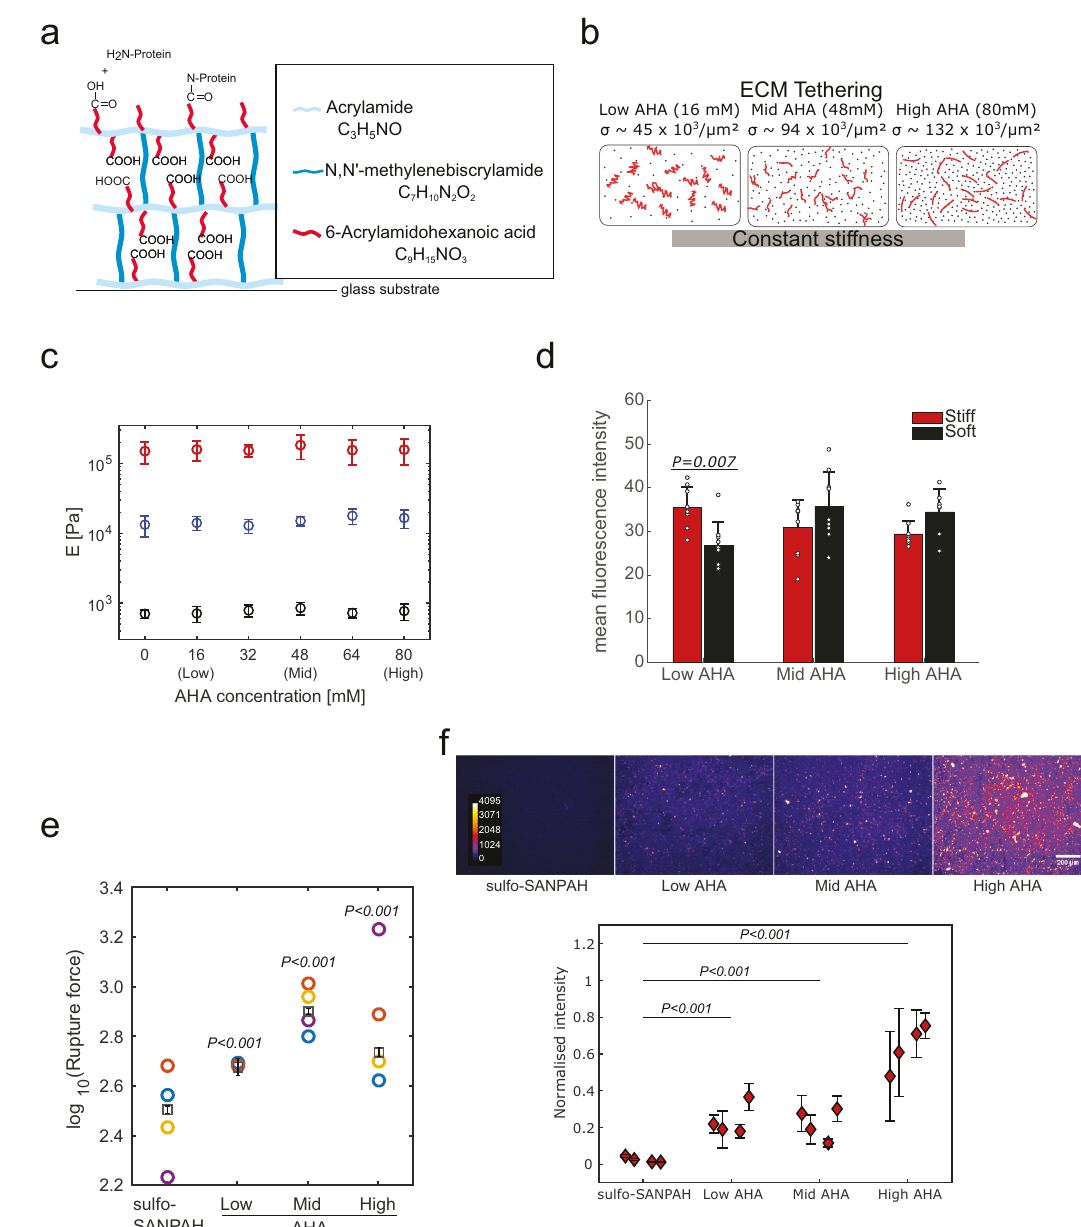
Fig. 1 StemBond hydrogels provide control over ECM density and stability independent of stiffness. a Sketch of StemBond hydrogels. PAAm are synthesised with co-factor 6-Acrylamidohexanoic acid (AHA). The AHA chains terminate with a carboxyl group which then binds primary amines of ECM proteins. b Schematic of variations in ECM tethering strength with AHA concentrations. The estimated values of the surface density σ of carboxyl groups (black dots) is given for three different concentrations (see the “ Methods ” section). Each ECM protein fi bre (red lines) can create many covalent bonds so different AHA concentrations will lead to different tethering strengths while not affecting the stiffness. c Young ’ s modulus of StemBond hydrogels with different proportions of acrylamide, bis-acrylamide and AHA co-factor was measured using AFM. The modulus in Pa is reported (mean± standard deviation) (30 indentations/gel over 5 independent samples) for soft (black), intermediate (blue) and stiff (red) hydrogels. d Quanti fi cation of protein coverage on StemBond hydrogels, estimated by coating gels with FITC-labelled BSA and measuring the mean fl uorescence intensity at the gel surface ( n = 2 – 3 fi elds of view for three independent samples). Bars show mean ± standard deviation. P -values computed using a one-way ANOVA with Tukey – Kramer ’ s multiple comparison test. e Rupture force (log 10 ) from signi fi cant binding events between fi bronectin bound onto hydrogels and an AFM probe coated with anti-Fibronectin antibody. ‘ ○ ’ : average of n = 3 or 4 independent experiments; ‘ □ ’ : overall mean; bars: standard error. P -values correspond to pairwise comparison to sulfo-SANPAH substrates from two-way ANOVA linear model. f Rhodamine-Fibronectin layer on different stiff substrates after 3 days of MEFs culture. (Top) Holes in the ECM layer are sites of ECM remodelling by MEFs. (Bottom) Mean± standard deviation of fl uorescence intensity for four replicates ( n = 12 – 17 frames/data point taken over two independent experiments). Mean intensities were normalised for each batch and background was subtracted (measured on uncoated substrates) before averaging. P -values computed using a one-way ANOVA with Tukey – Kramer ’ s multiple comparison test. In panels e and f , all hydrogels were coated with 200 µ g ml − 1 fi bronectin. Source data are provided as a Source Data fi